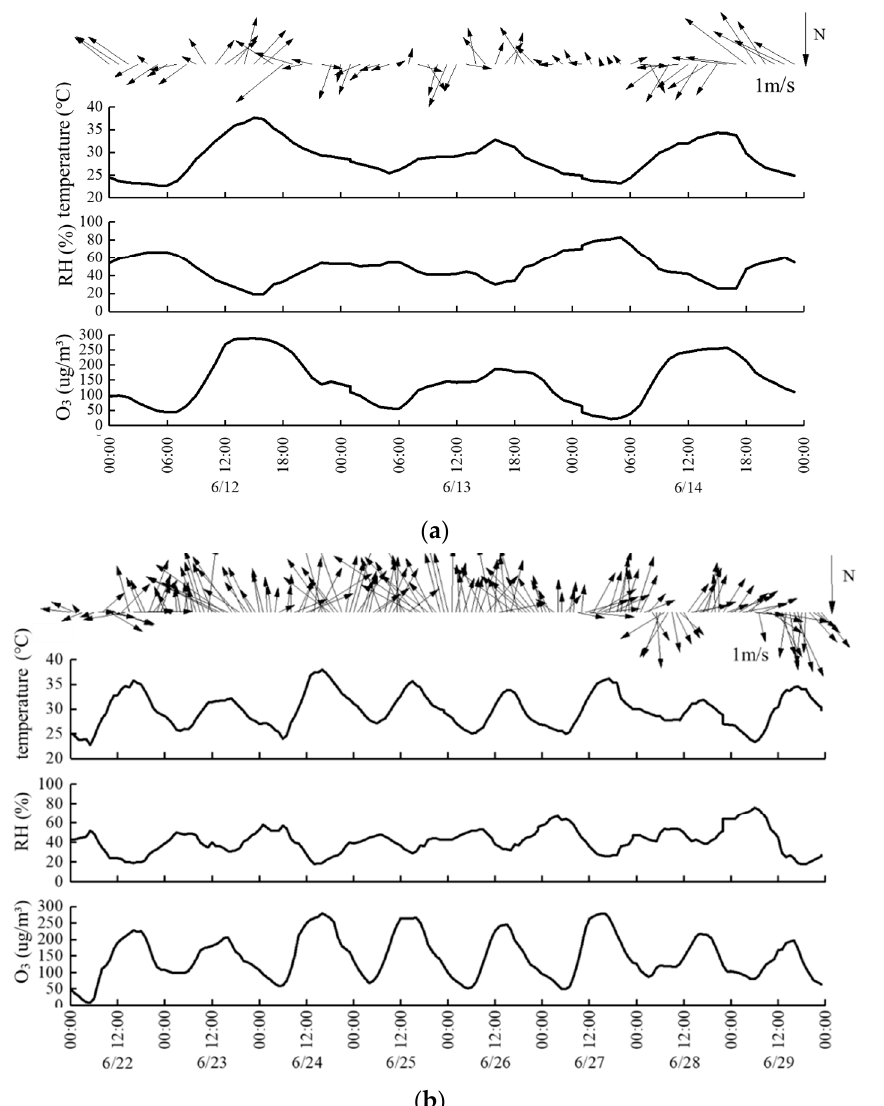
Figure 6. Diurnal variation of pollutant concentration and meteorological element from ( a ) June 12 to 14 and ( b ) June 22 to 29.